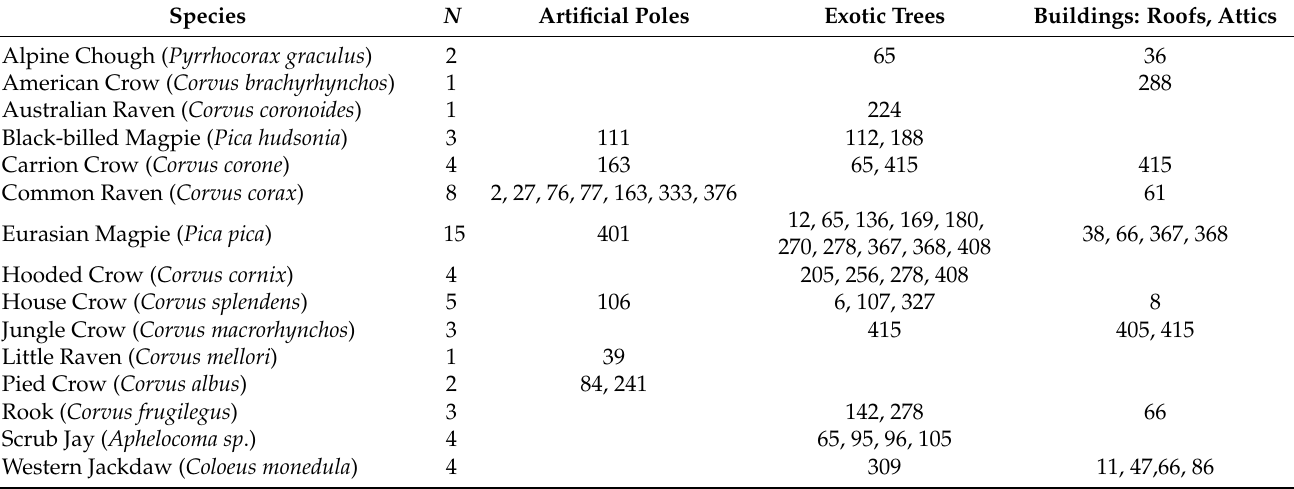
Table 4. List of articles in relation to artificial nest site selection ( n = 47). The reference numbers in the table refer to the individual publication numbers given in Table